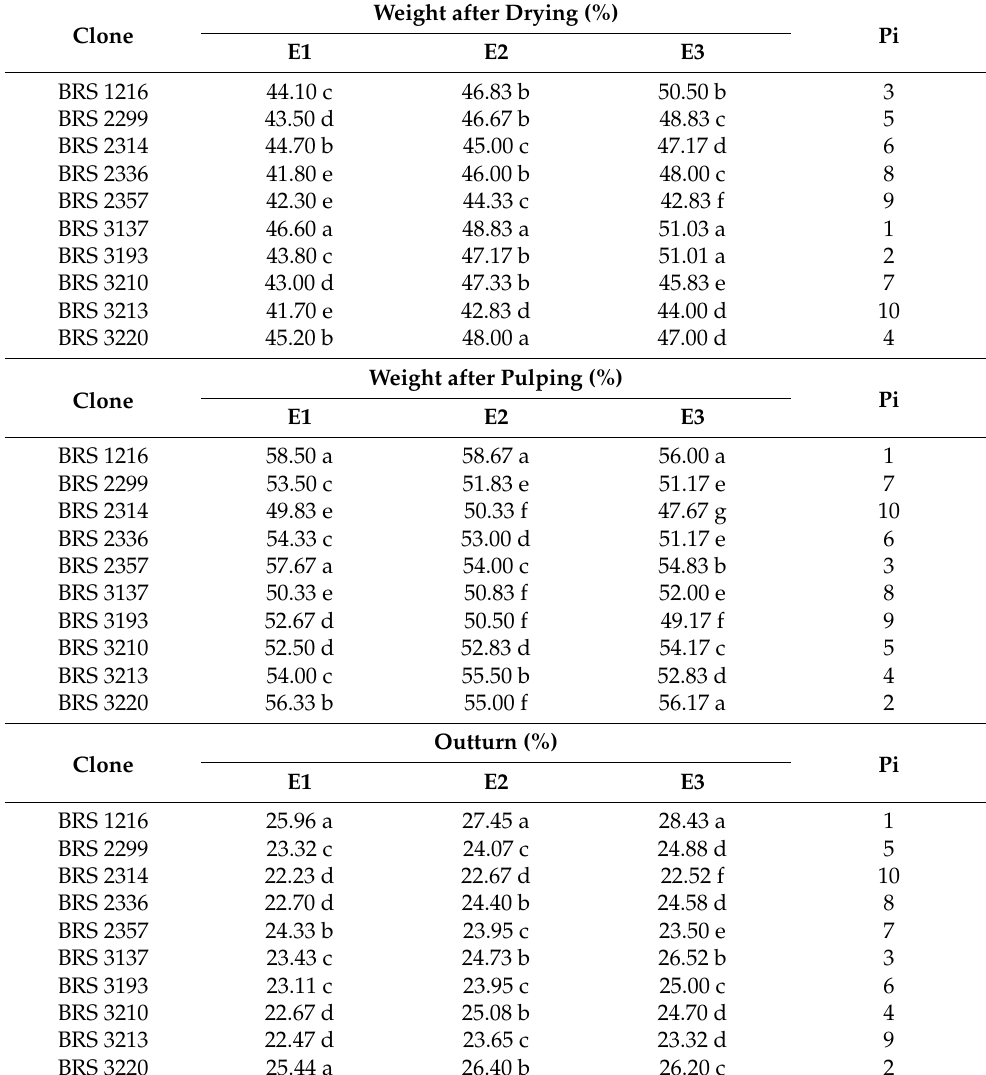
Table 4. Weight after drying, after pulping, and outturn index of ten Amazonian Robusta cultivars evaluated in three environments of the Western Amazon: E1—Porto Velho dryland, E2—Ouro Preto do Oeste dryland, E3—Ouro Preto do Oeste